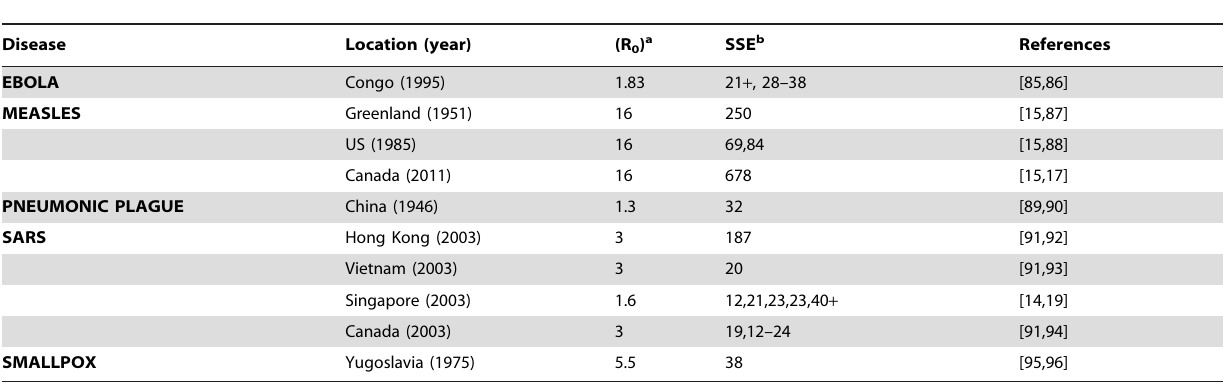
Table 1. Superspreading events during infectious disease outbreaks.